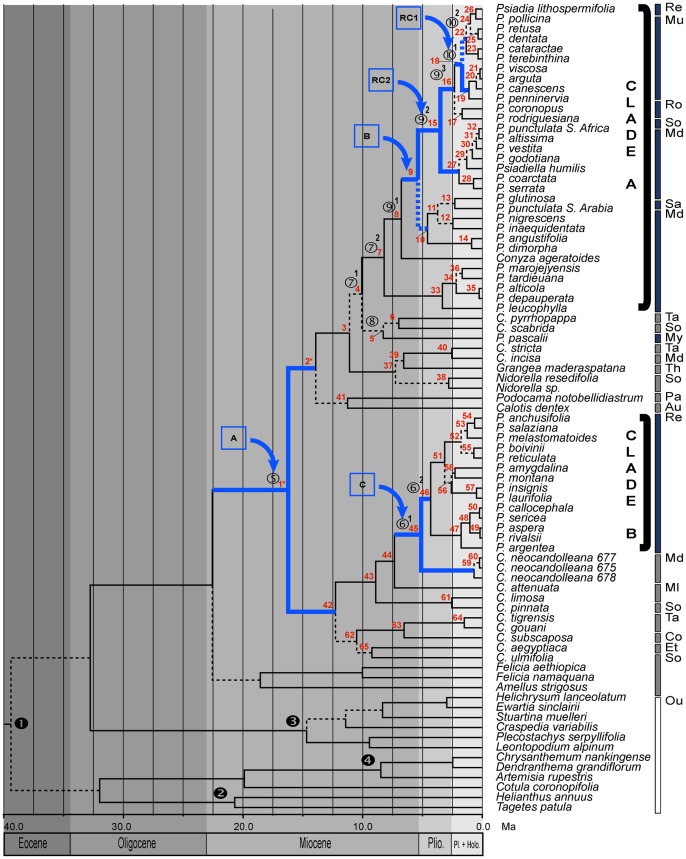
Chronogram for Psiadia s.l. and results of diversification rate shift analyses.Broken branches lead to nodes with low posterior probabilities (<90) obtained in BEAST. Arrows indicate rate shifts associated with results obtained using SYMMETREE (rate shift box A, B & C: Δ1, Δ2 and SG) and the Relative Cladogenesis test (RC1 & RC2). Numbered nodes 1–4 indicate calibrated nodes. Numbered Nodes 5–10 refer to key events in the evolutionary history of Psiadia, as discussed in text. Bars: blue, Psiadia clade A & B; grey, other taxa contained with Psiadia-clades; white, outgroup taxa. Abbreviations: Re (Réunion), Mu (Mauritius), Ro (Rodrigues), Md (Madagascar), So (South Africa), Sa (Saudi Arabia), Ta (Tanzania), My (Mayotte), Th (Thailand), Pa (Paraguay), Au (Australia), Ml (Malawi), Co (Congo-Kinshasa), Et (Ethiopia), Ou (Outgroups).